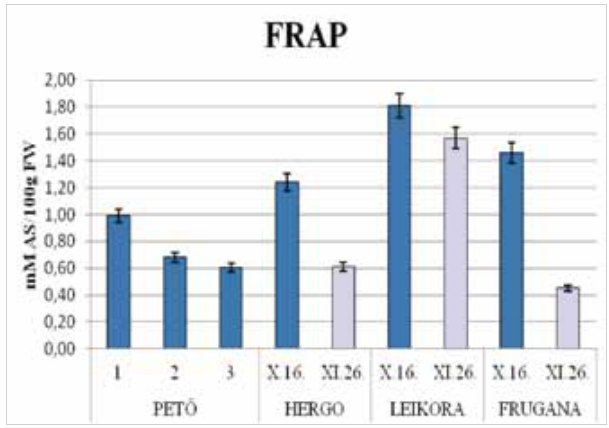
Figure 1. Antioxidant capacity in sea buckthorn berries according to genotypes and harvest times